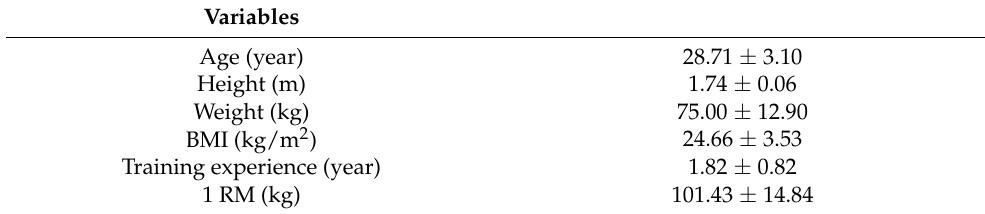
Table 1. Characteristics of participants.